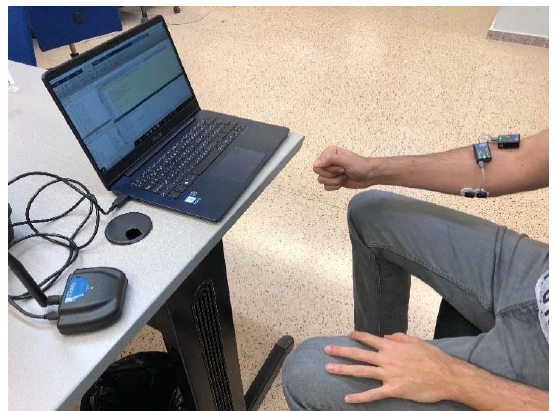
Figure 2. Surface electromyography (sEMG) system acquiring data from a subject.